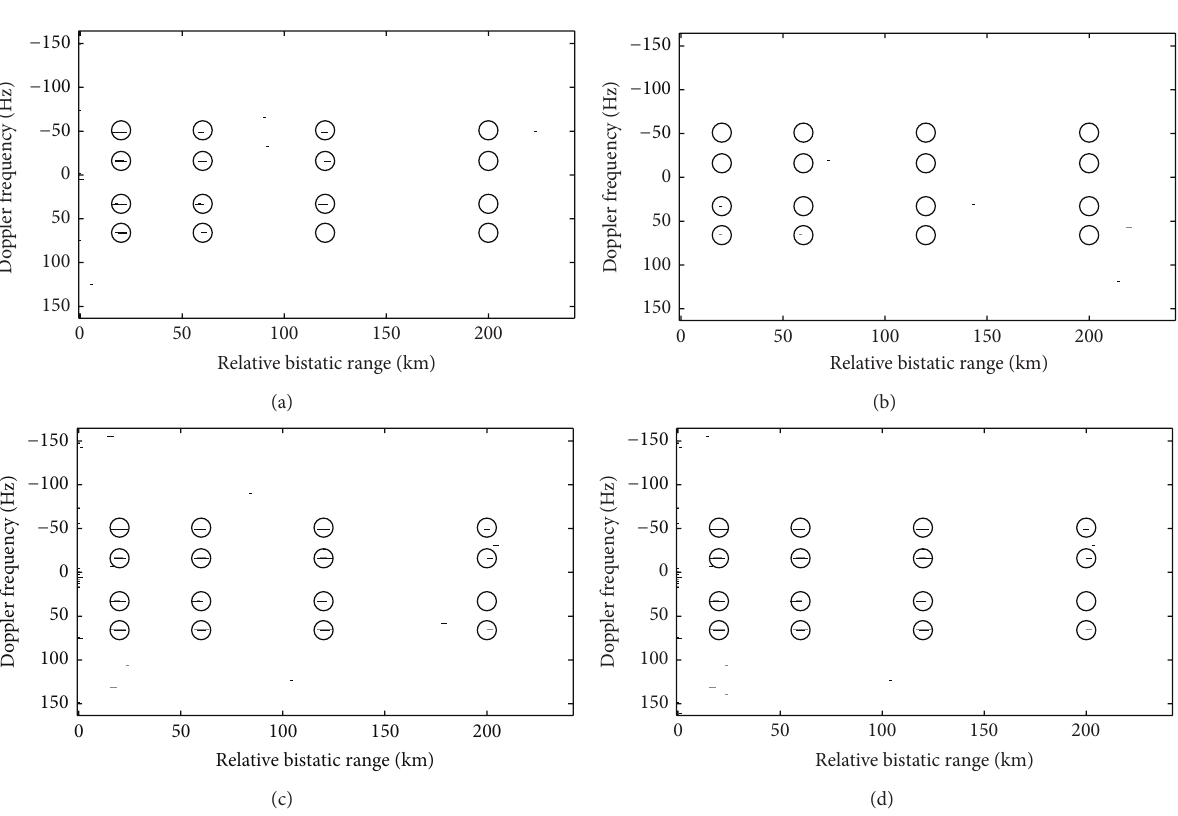
the resulting pattern does not differ significantly from the pattern obtained by using the true covariance matrix M